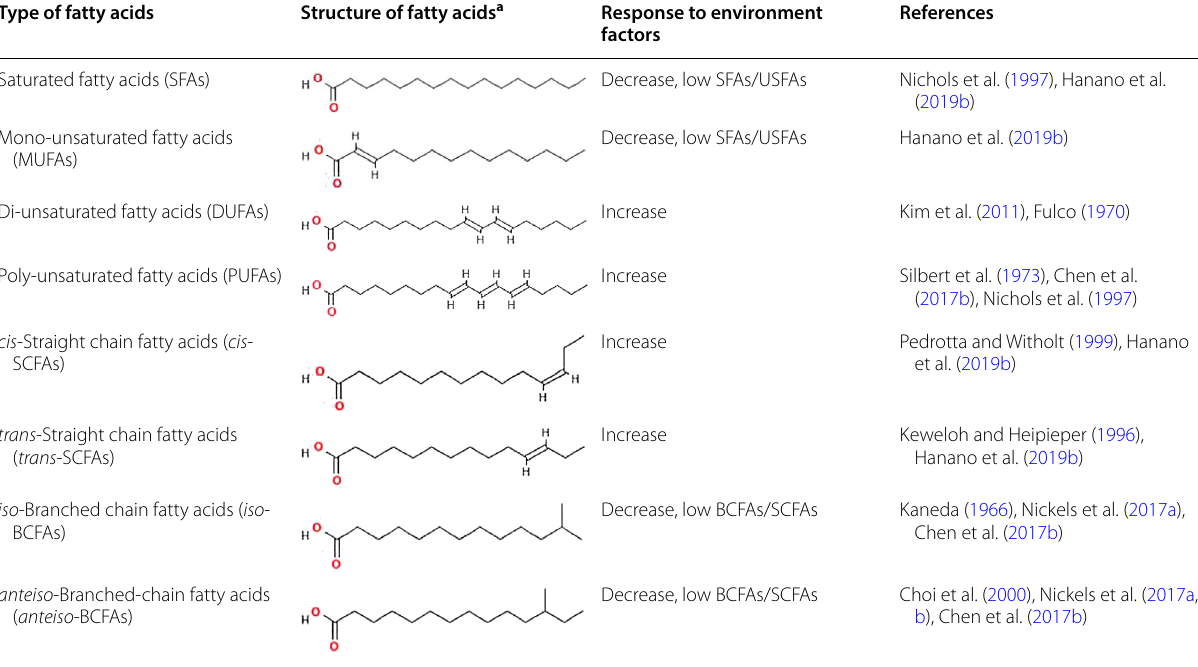
Table 2 Environmental implications of different types of microbial membrane